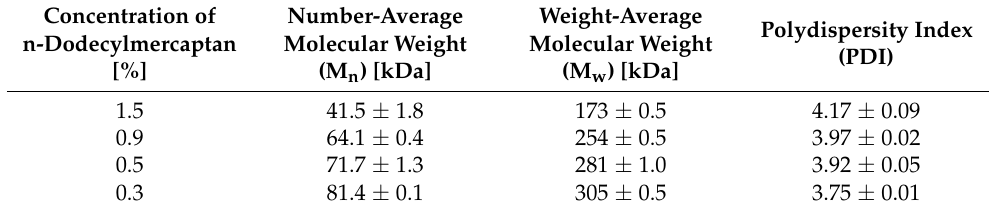
Table 3. M n , M w and PDI of the ModE copolymers determined via gel permeation chromatography (GPC) analysis. Each value designates the mean ± S.D. (n =